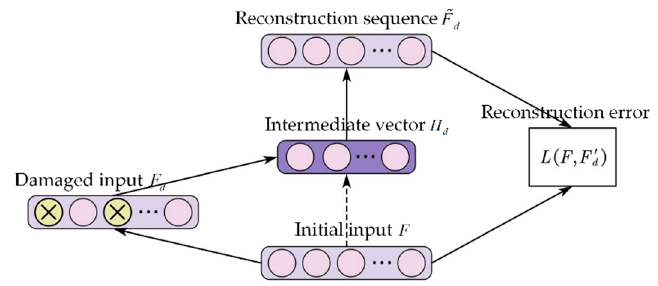
Figure 2. Architecture of the denoising auto-encoder.